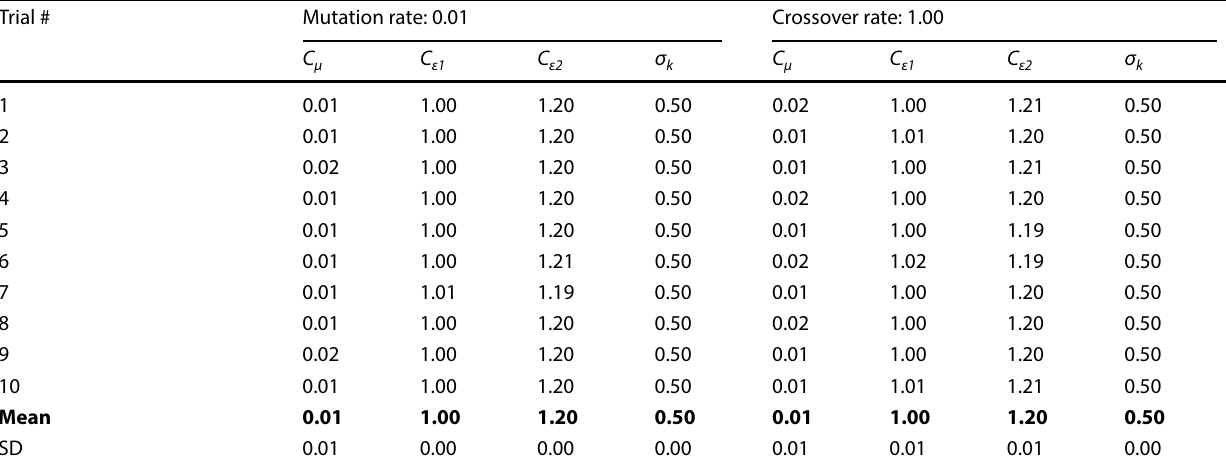
Table 9 Effect of mutation rate on GA-based simulation results for crossover rate 0.50 and channel configuration p/k = 10, H = 1.2 mm.